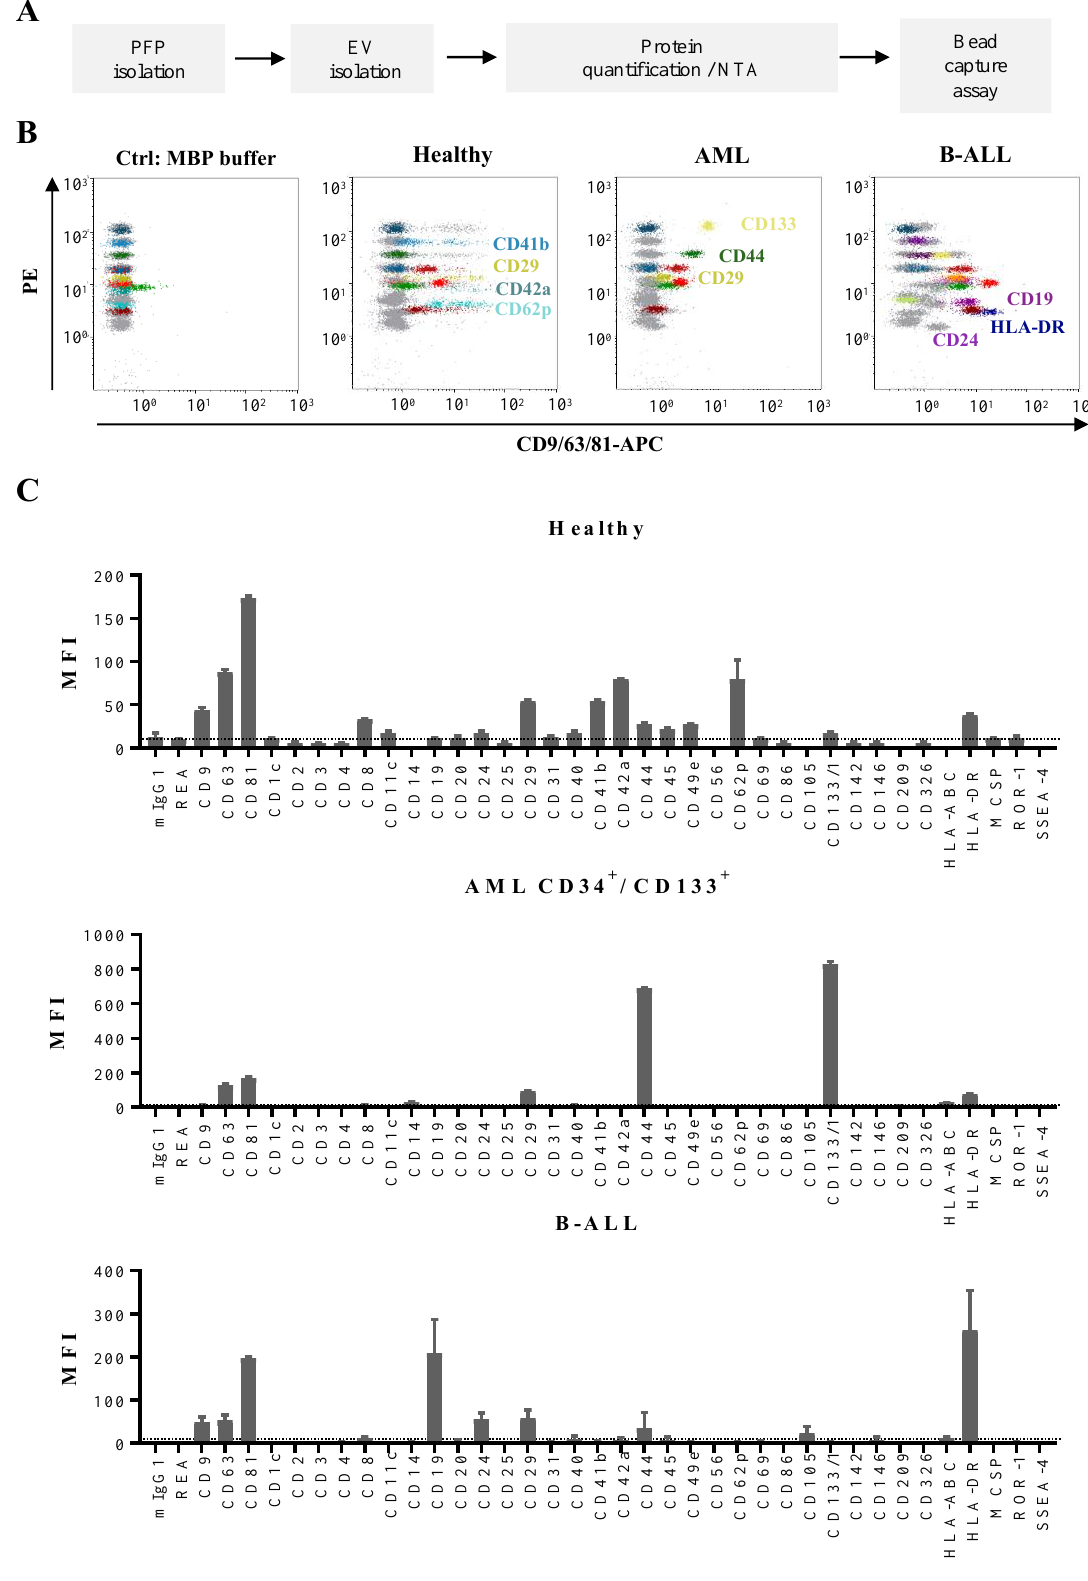
Figure 5. Multiplex bead-based flow cytometry assay: antigen profiling of EVs from PFP samples from leukemia patients at diagnosis and HBDs: ( A ) Experimental outline of multiplex bead-based detection of EV antigen profiles. The